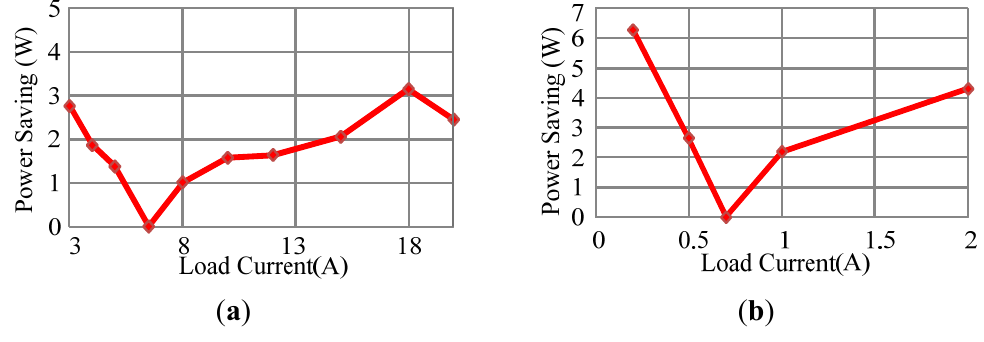
Figure 31. Energy saving by adopting the proposed control method ( a ) at mid and heavy loads; ( b ) at light